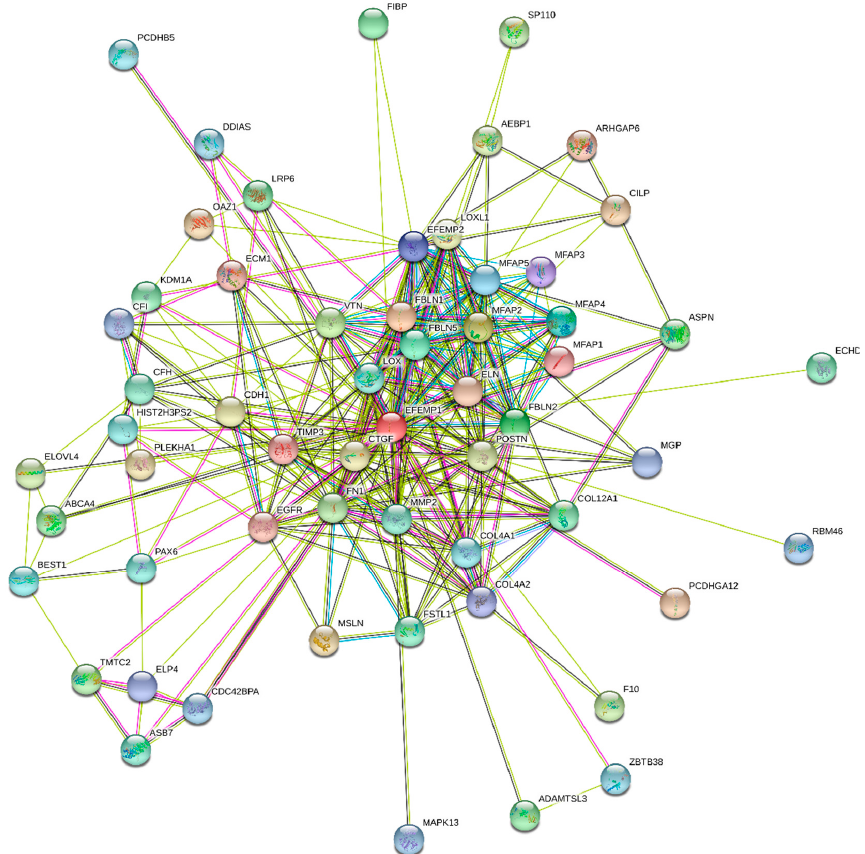
Figure 2. Search Tool for the Retrieval of Interacting Genes (STRING)-based analysis of human fibulin-3 (UniProt ID: Q12805) using the minimum required interaction score of 0.4 (medium confidence). STRING generates a network of predicted associations based on predicted and experimentally validated information on the interaction partners of a protein of interest. In the corresponding network, the nodes correspond to proteins, whereas the edges show predicted or known functional associations. Seven types of evidence are used to build the corresponding network, indicated by the differently coloured lines: a green line represents neighborhood evidence; a red line—the presence of fusion evidence; a purple line—experimental evidence; a blue line—co-occurrence evidence; a light blue line—database evidence; a yellow line—text mining evidence; and a black line—co-expression evidence.